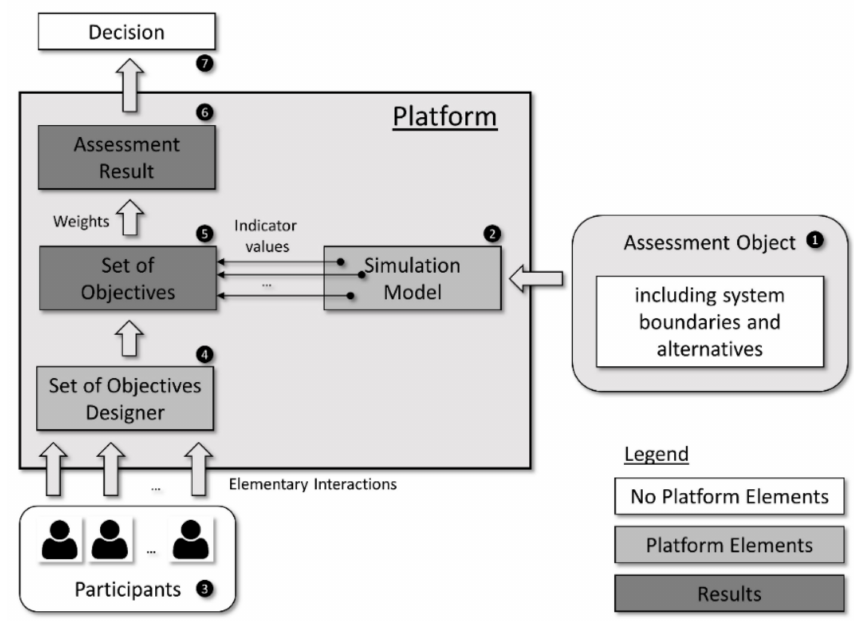
Figure 3. System